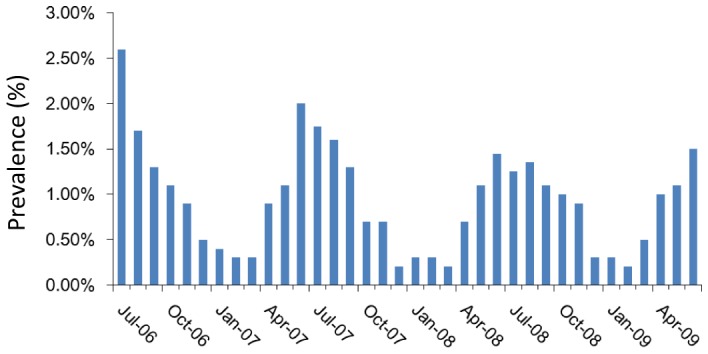
Temporal distribution of prevalence of Plasmodium falciparum malaria based on the U.N. populations at the UNMIS level 2 hospital in Wau, July 2006–June 2009.